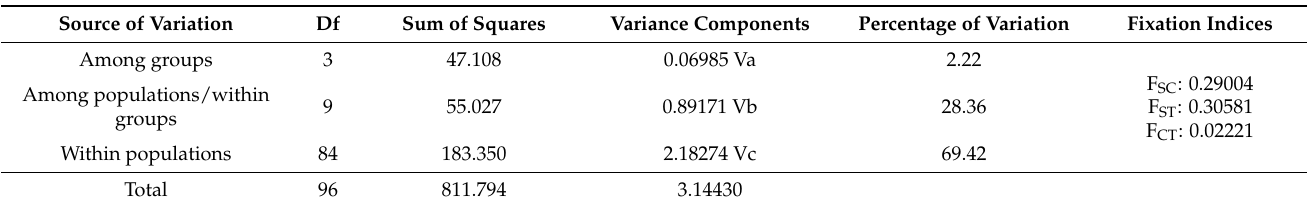
Group: Pillareño vs. Europeans, Iberic, and commercial. Variance for group, Va; variance for population, Vb; variance for haplotypes within a population within a group, Vc; permuting haplotypes among population among groups, F ST ; permuting haplotypes among populations within groups, F SC ; permuting populations among groups, F CT . Df; Degrees of